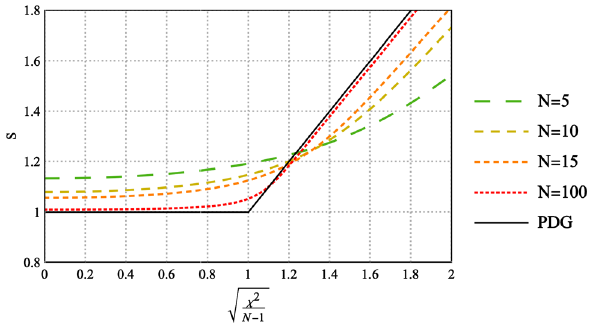
Fig. 9 Scaling for α =